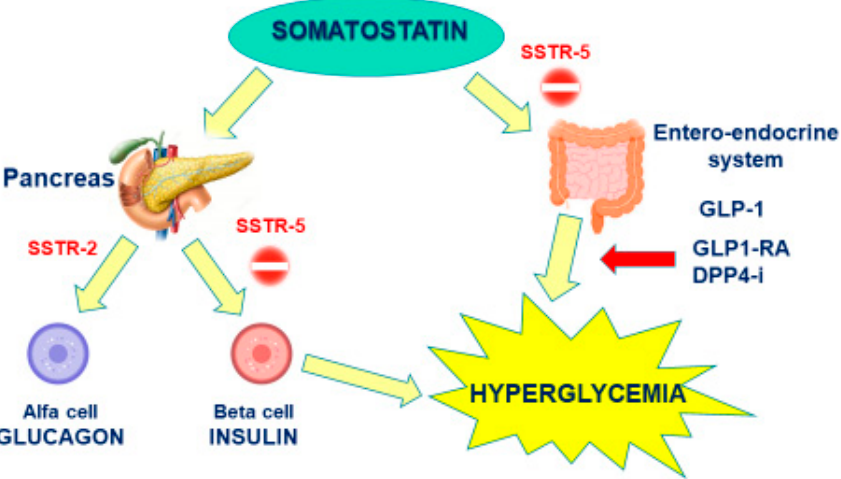
Figure 1. Mechanism of Pasireotide-induced Hyperglycemia.